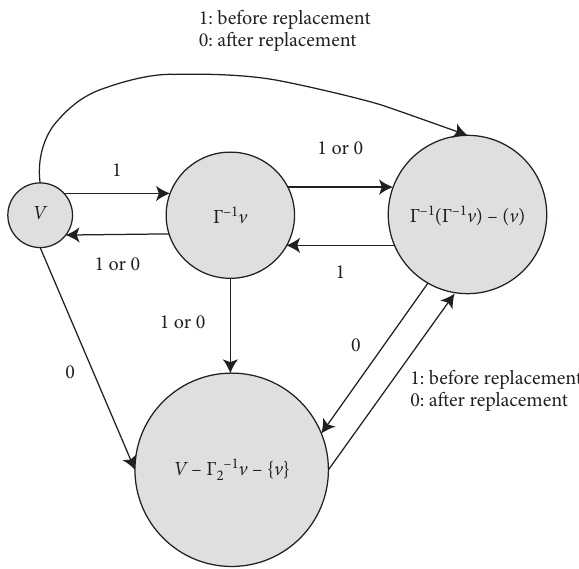
Figure 2: A syndrome of Corollary